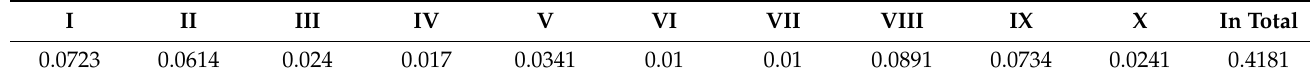
Table A5. Results by items (Sales and Customer Care Area).